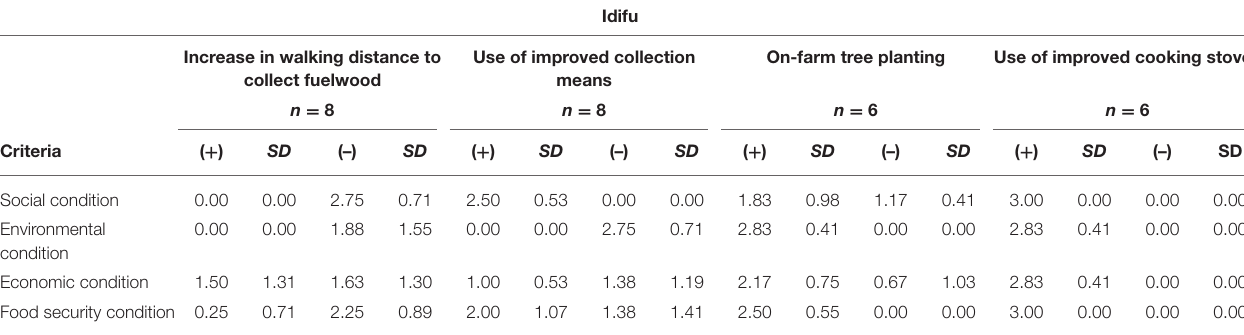
TABLE 6 | Results of the impact assessment of Idifu with the positive ( + ) and negative (–) ratings.